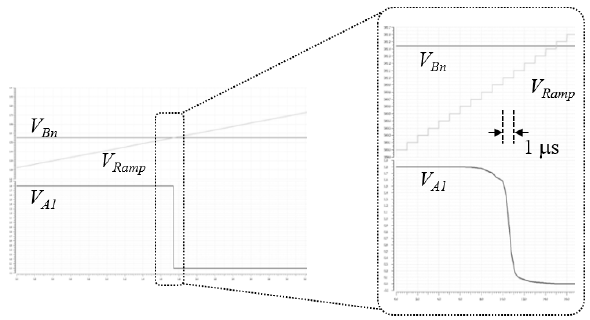
Figure 8. Simulated waveforms for determining V Bn .